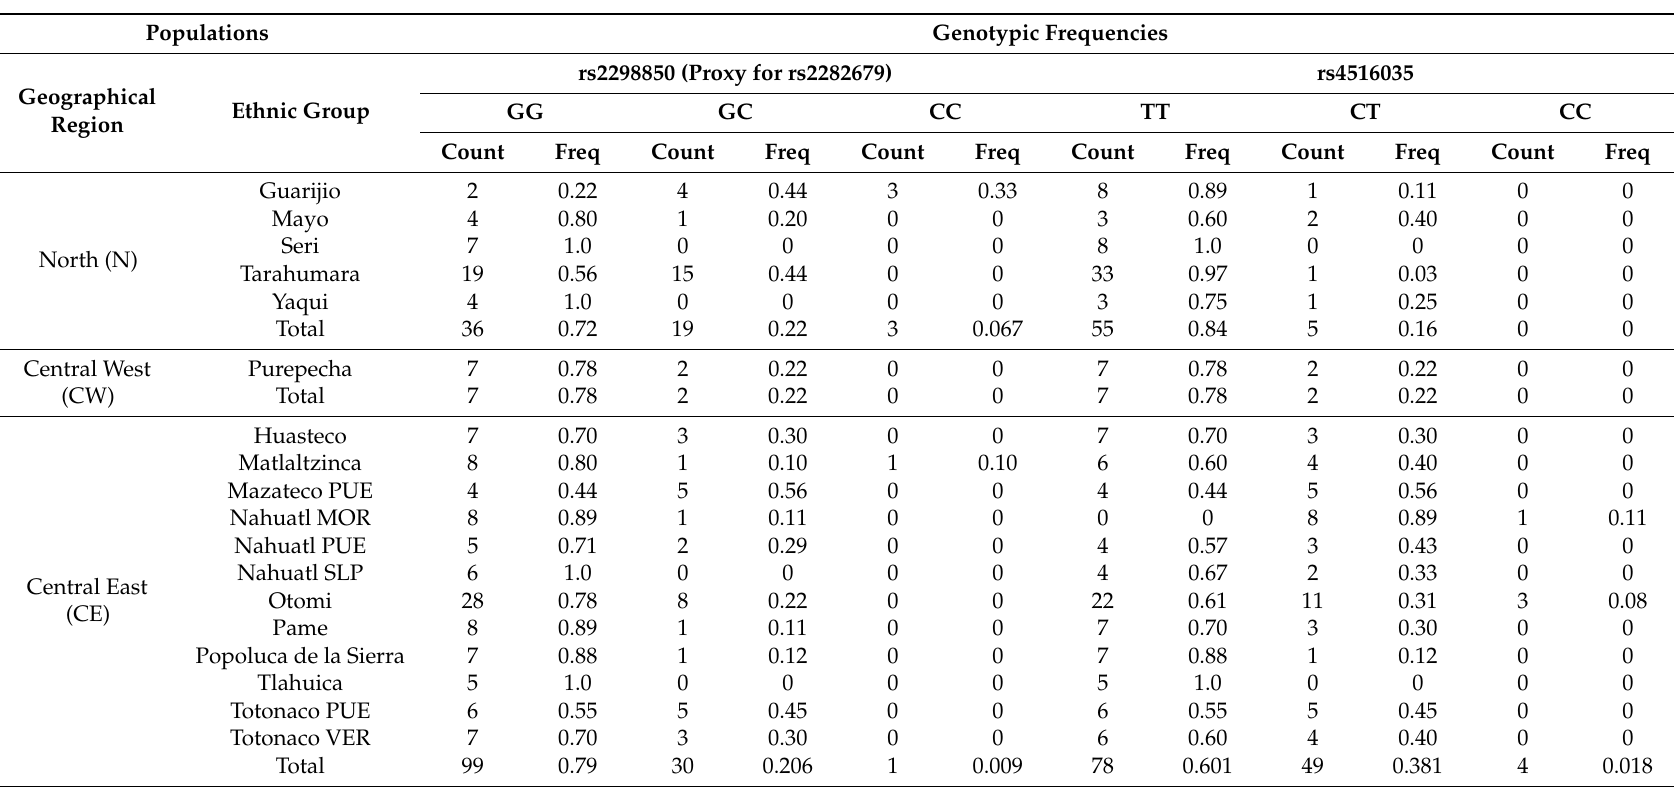
Table 4. Genotype frequencies of GC and VDR variants in 37 Mexican Amerindian